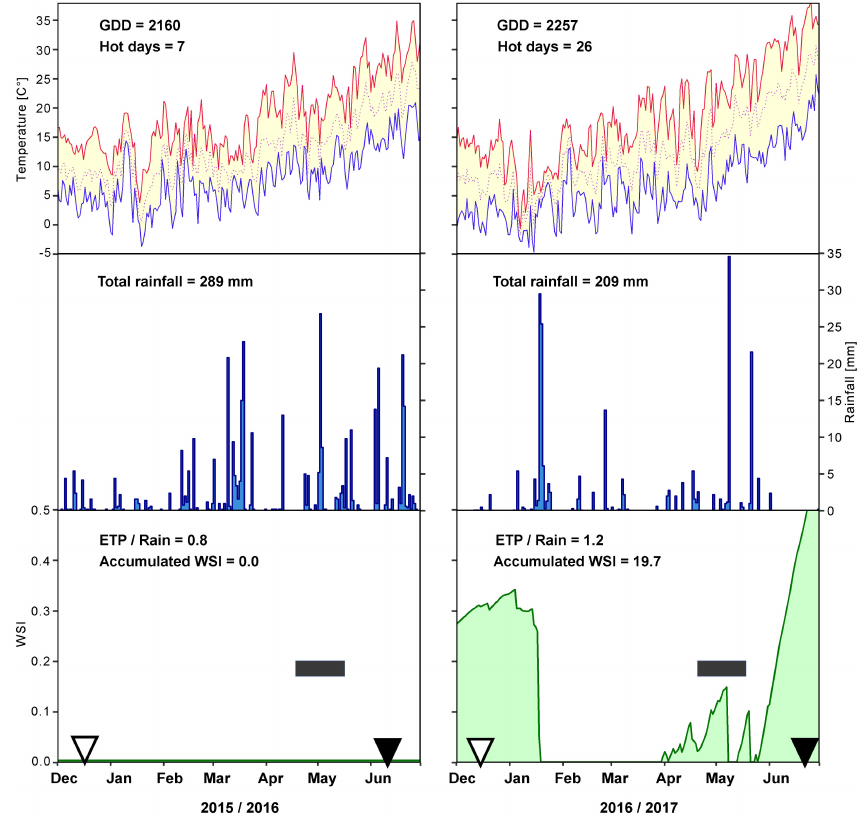
Figure 1. Agro-meteorological characterization of the 2015 / 2016 and 2016 / 2017 cropping seasons in Foggia, Italy. Maximum, minimum, and average temperature ( ◦ C, upper panels), rainfall distribution (mm, middle panels), and water stress index (WSI, lower panels) are reported. Empty and full arrowheads indicate sowing and harvest dates, respectively, while grey horizontal bars indicate